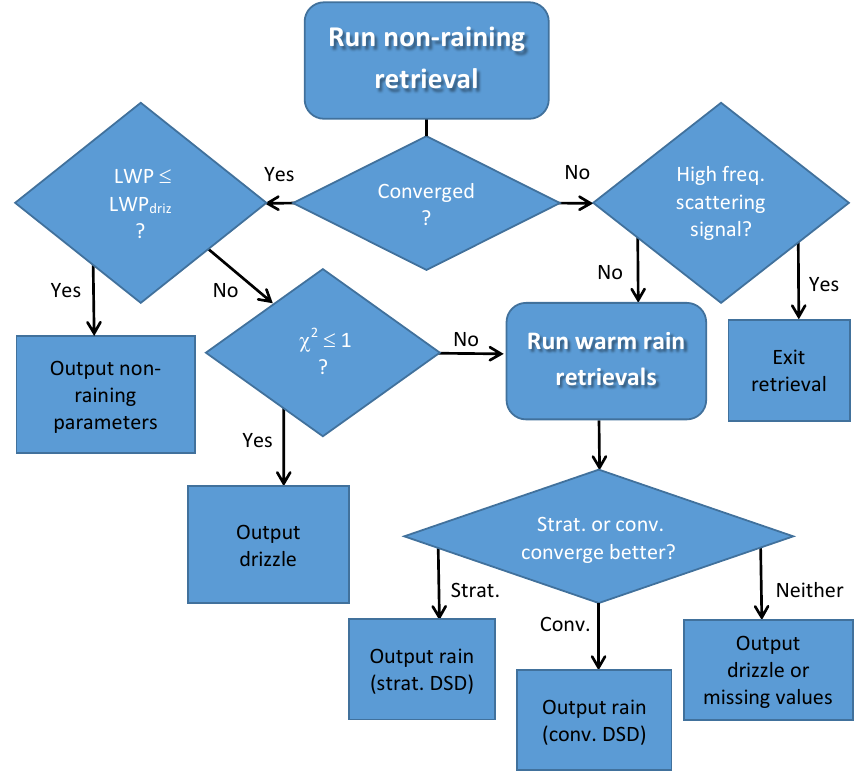
Figure 6. Algorithm flowchart for the 1DVAR for warm rain.